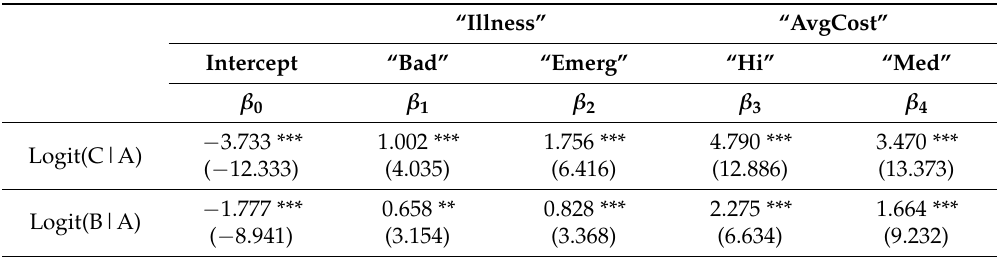
Table 6. Modelling financial burden following cost levels and illness.